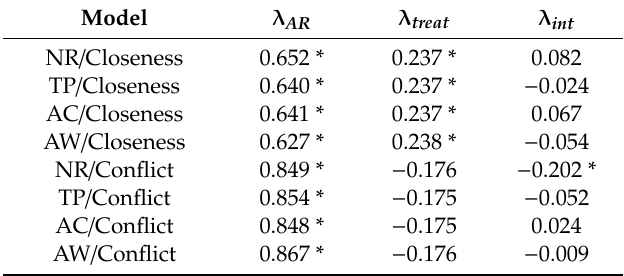
Table 5. Estimates of focal parameters for three-level regression models.